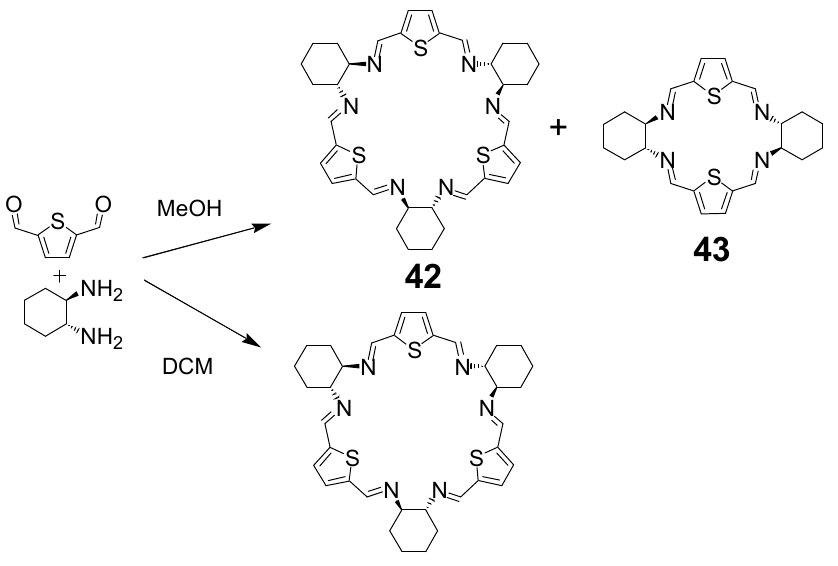
Figure 15. Macrocycles from 2,6-diformylthiophene.